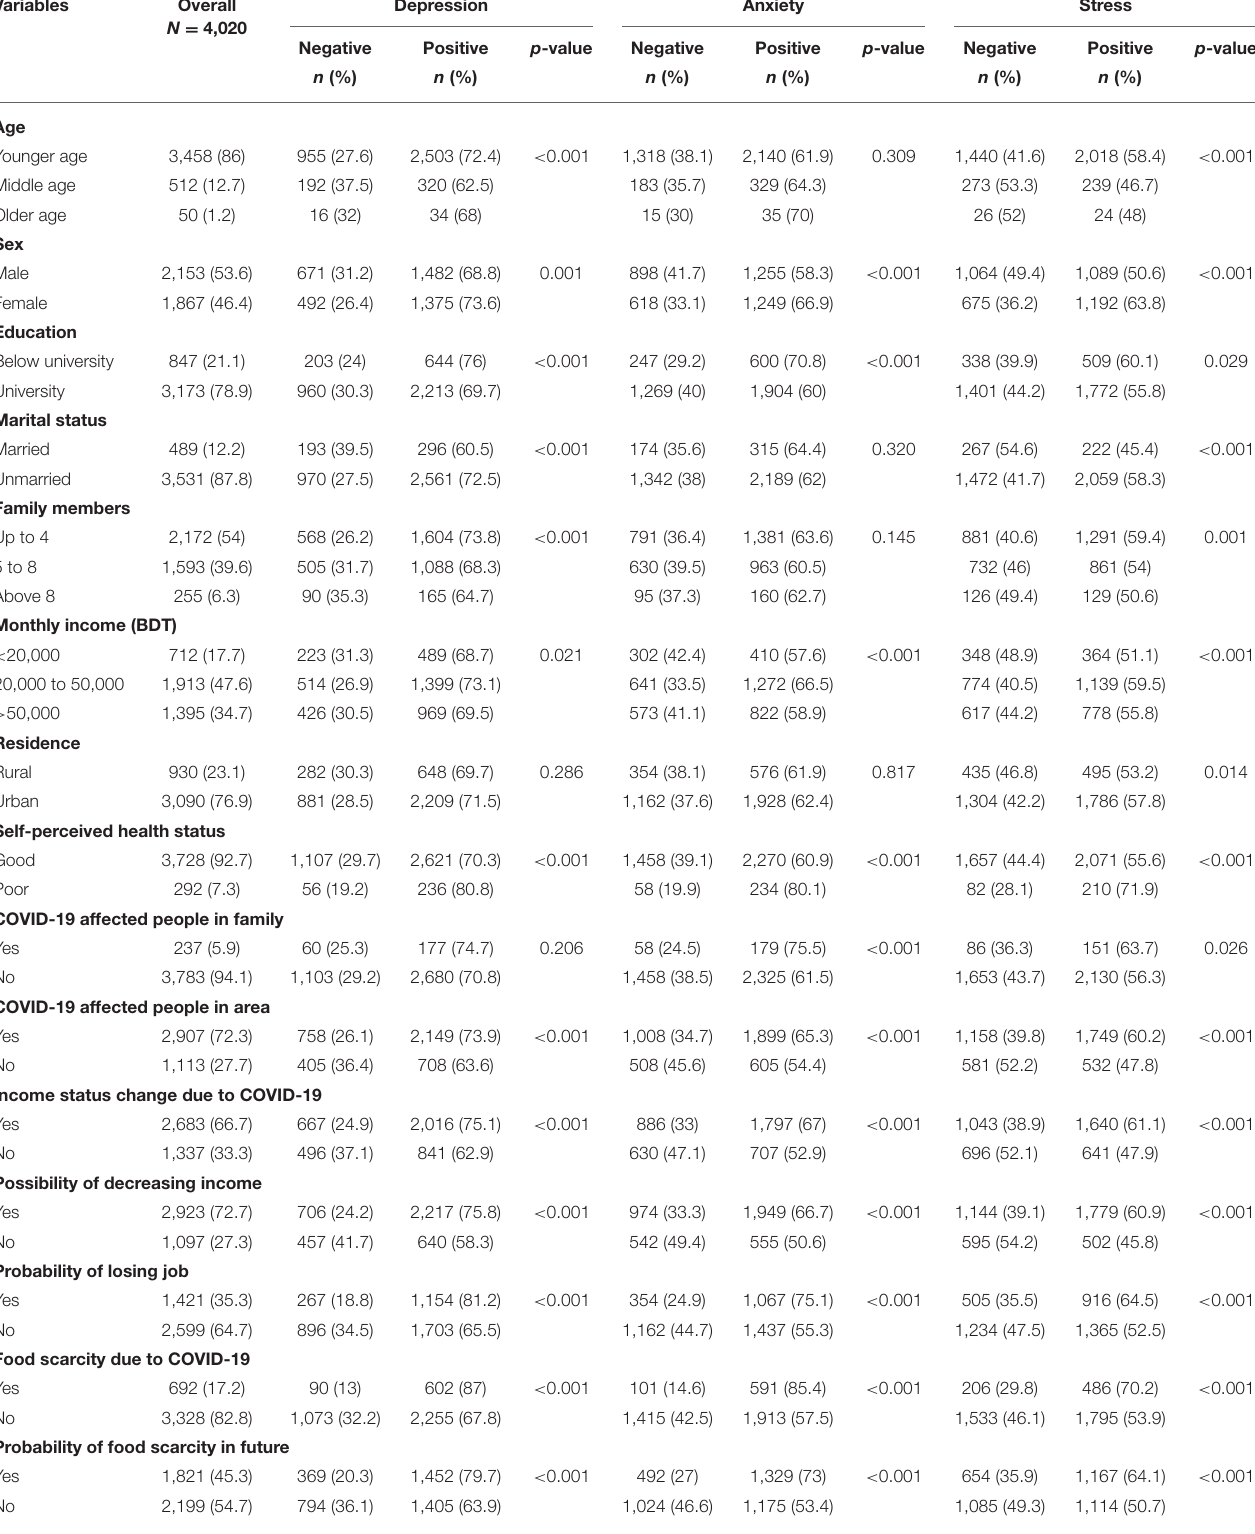
TABLE 1 | Distribution of all examined variables and association with depression, anxiety, and stress. Variables Overall Depression Anxiety Stress N = 4,020 Negative Positive p -value Negative Positive p -value Negative Positive p